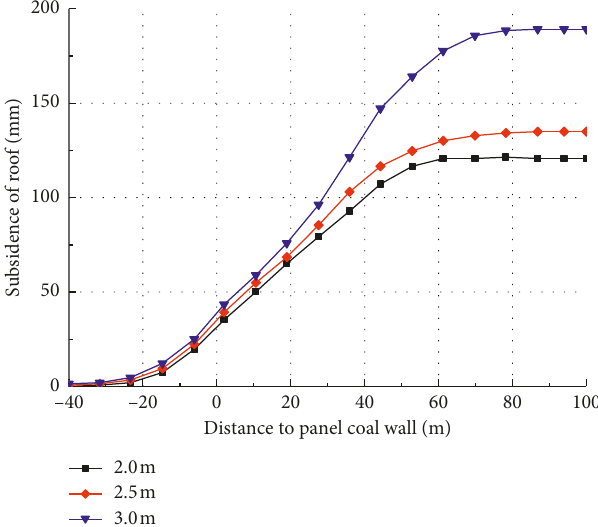
Figure 13: Relations between surface displacement of surrounding rock in the roadway and filling body